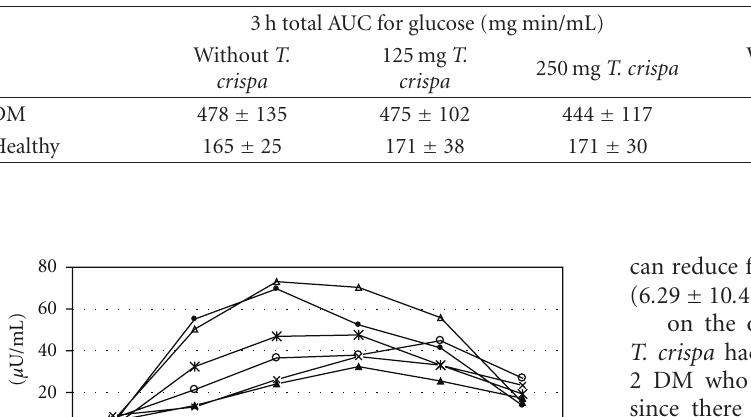
Table 2: Mean of 3h total area under the curve (AUC) glucose and 3-h total AUC insulin for 75 g oral glucose tolerance test performed with and without 125 or 250 mg of Tinospora crispa .